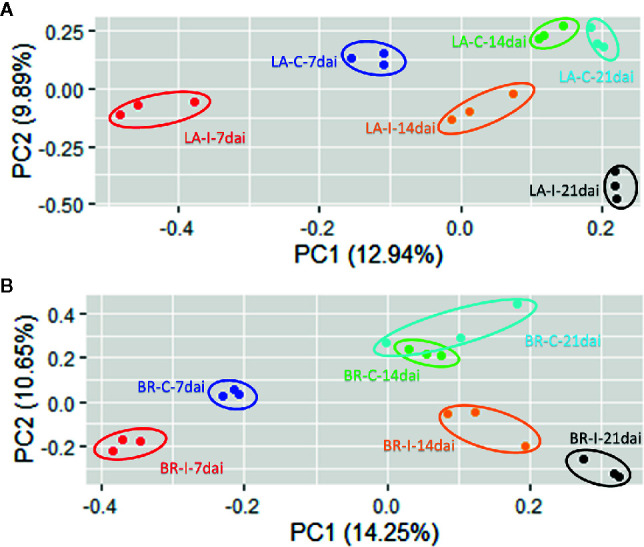
Principal Component Analysis (PCA) plots for RNA-seq data in each genotype. The three biological replicates corresponding to each treatment (control vs. inoculation) in the three time points tested (7, 14 and 21 dai) show consistent clustering for both host genotypes, Brassica napus ‘Laurentian’ and ‘Brutor’. (A) Laurentian PCA plot. (B) Brutor PCA plot. ID codes: LA, Laurentian; BR, Brutor; I, Inoculated; C, Control; number after I or C stands for number of days after inoculation (dai).